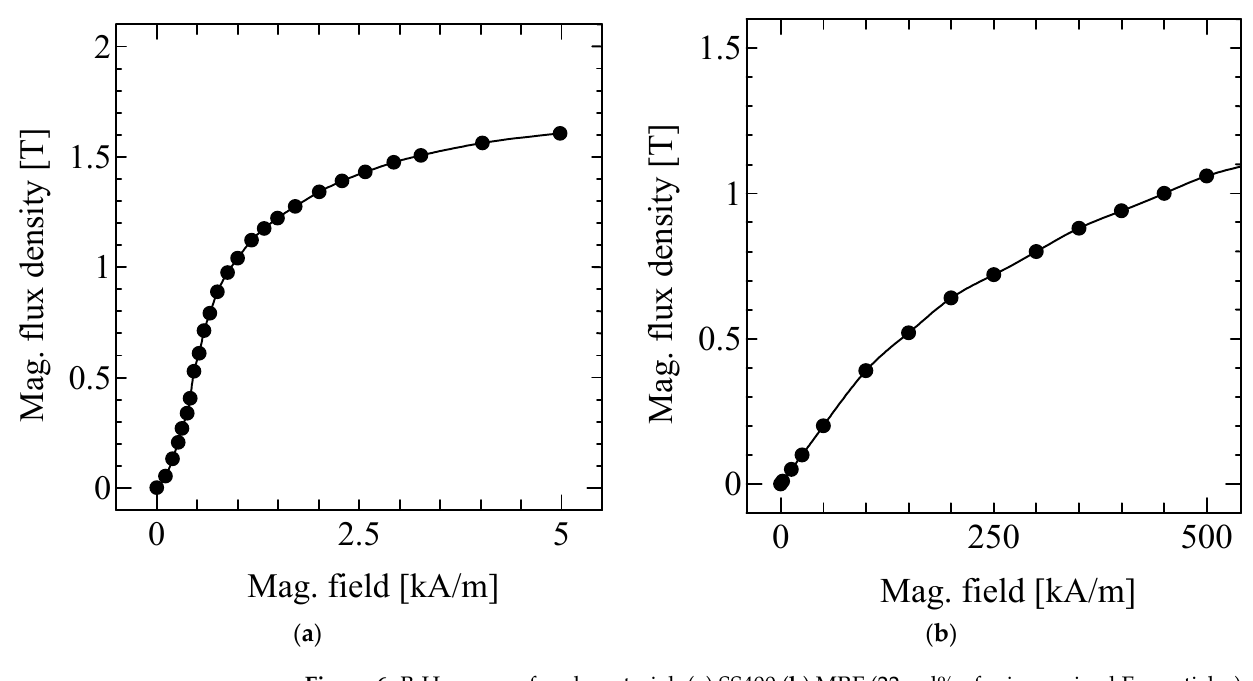
Figure 6. B-H curves of each material. ( a ) SS400 ( b ) MRF (22 vol% of micron-sized Fe particles).